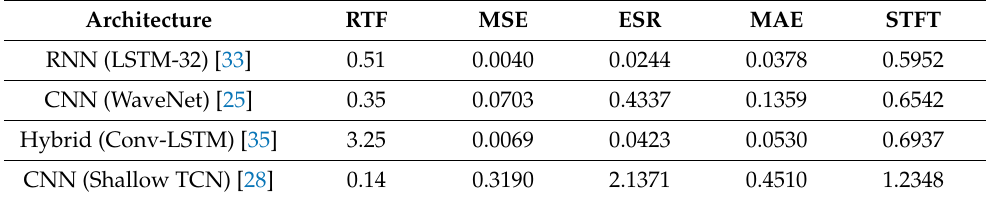
Table 8. Black-box architecture